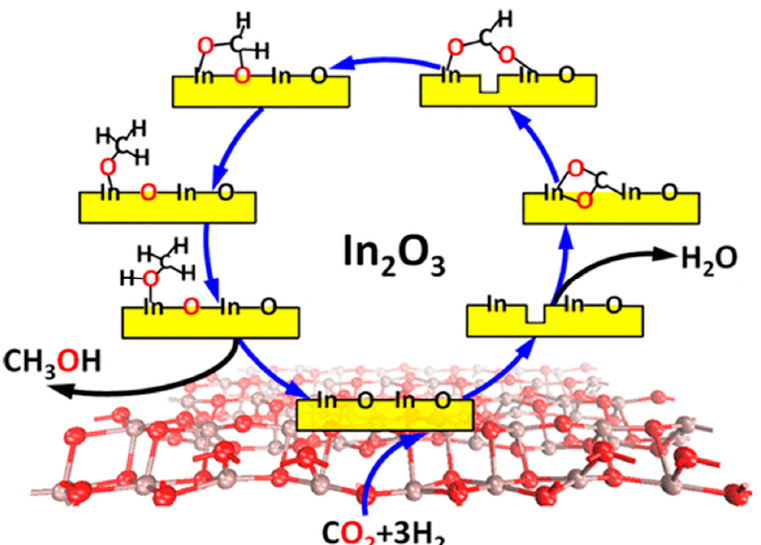
Figure 1. The active site and catalytic mechanism of CO 2 hydrogenation to methanol over defective In 2 O 3 (110). Reproduced with permission from ref. [53]. Copyright 2013 American Chemical Society.